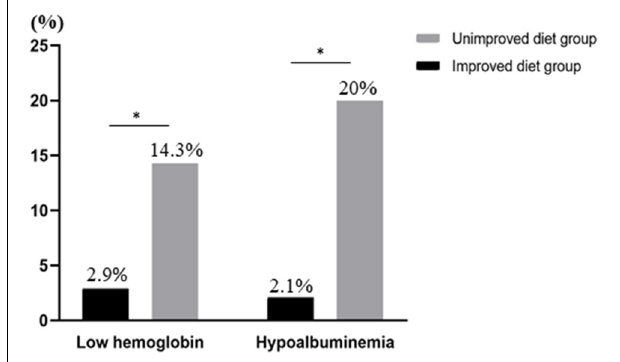
FIGURE 4 | Comparison of low hemoglobin and hypoalbuminemia between the diet-improved group and the diet-unimproved group ( ∗ P <